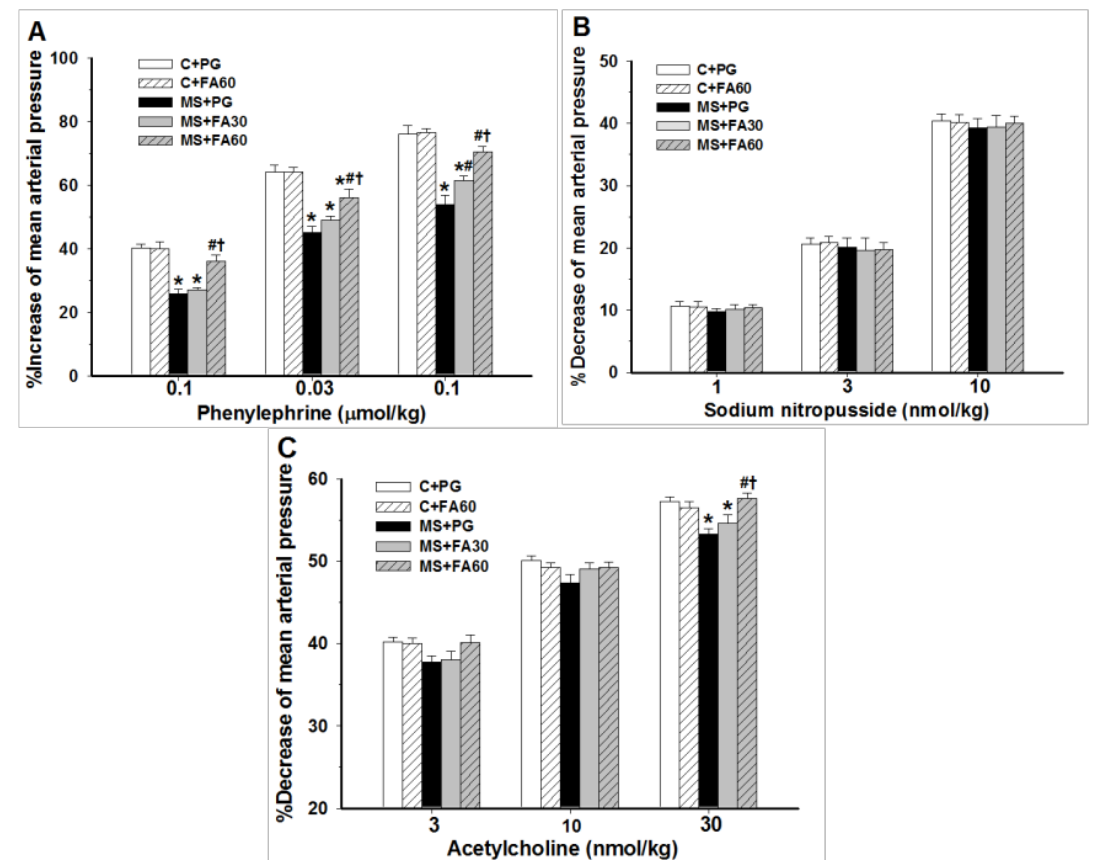
Figure 3. Effect of FA on vascular responses in MS rats. The blood pressure response in rats